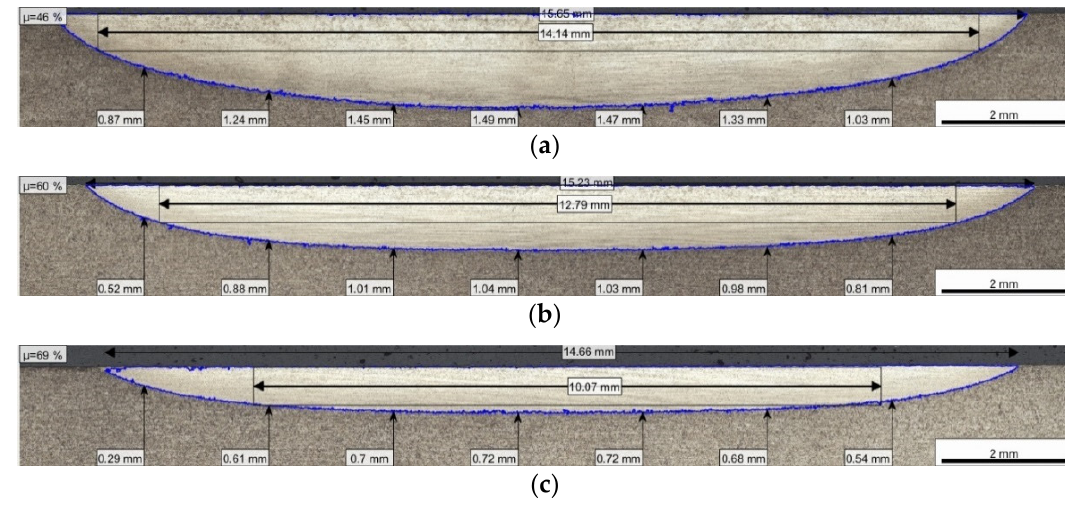
Figure 7. Analysis of the hardened track of the specimen after polishing and etching. The specimens were hardened with a top ‐ hat laser beam at a feed of 300 ( a ), 400 ( b ) and 500 mm/min ( c ).